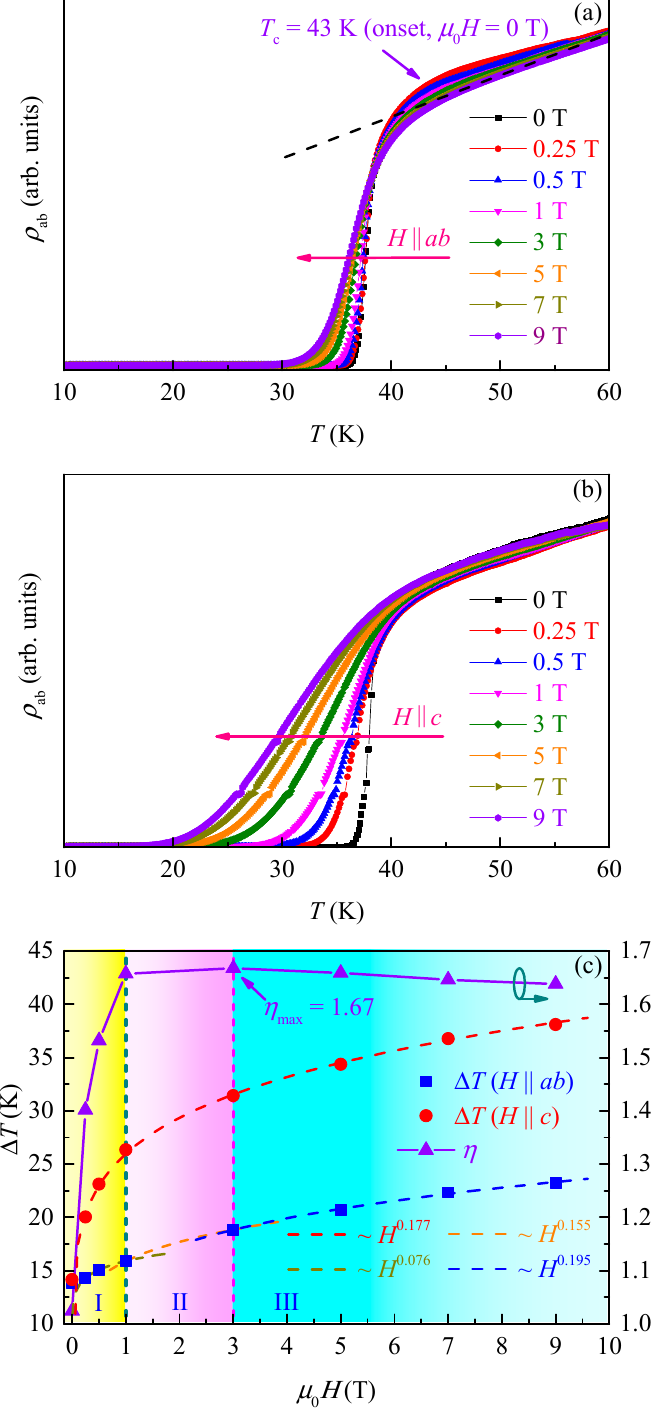
Figure 13. ρ ab - T relations for ( a ) H || ab and ( b ) H || c . ( c ) Δ T - μ 0 H and η - μ 0 H relations. η max = 1.67 at μ 0 H = 3 T.